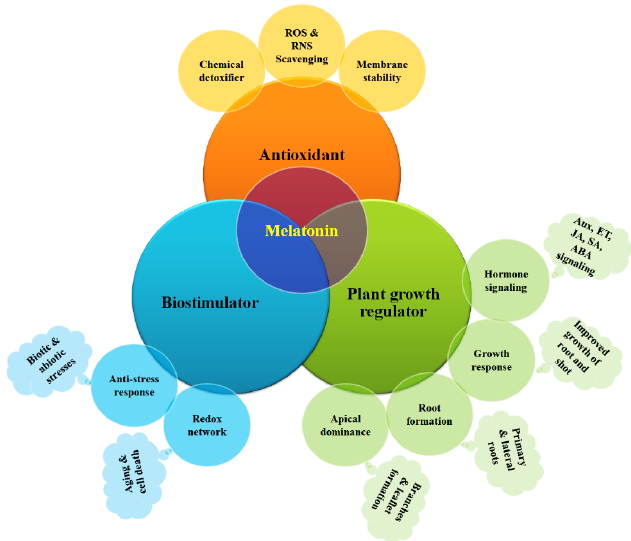
Figure 2. Mechanism of melatonin activities in plants as a growth regulator, bio-stimulator, and antioxidant. Here, ROS, RNS, Aux, ET, JA, SA, ABA indicates reactive oxygen species, reactive nitrogen species, auxin, ethylene, jasmonic acid, salicylic acid, and abscisic acid, respectively.